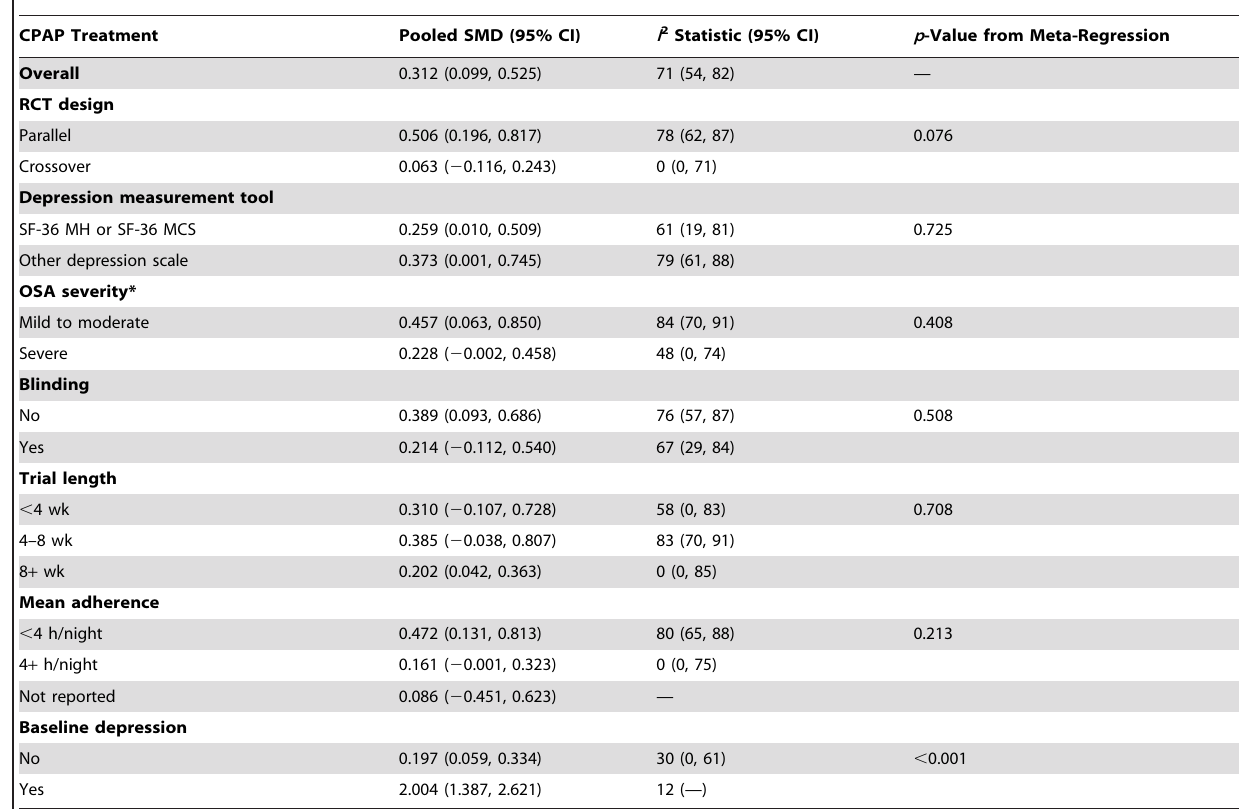
Table 4. Meta-regression analysis for effect of CPAP on depressive symptoms.